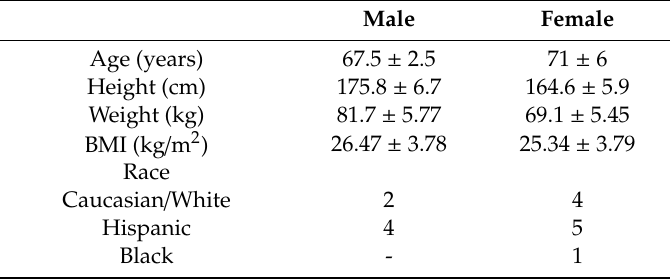
Table 1. Demographic characteristics of participants ( N =